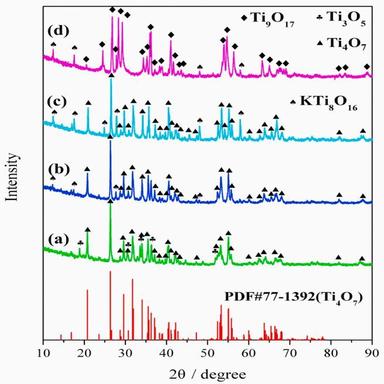
XRD patterns of the TiO2 coating with different thicknesses after sintering at 1000 ◦C for 1 h, (a) 40 μm, (b) 78 μm, (c) 118 μm, and (d) 246 μm.